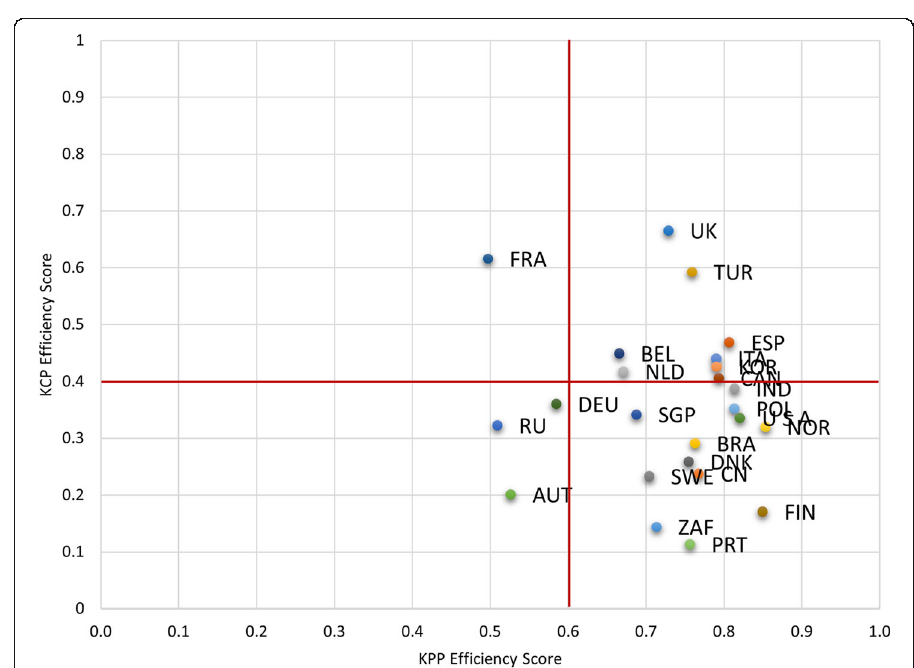
Fig. 3 NISs classification based on bias-corrected DEA